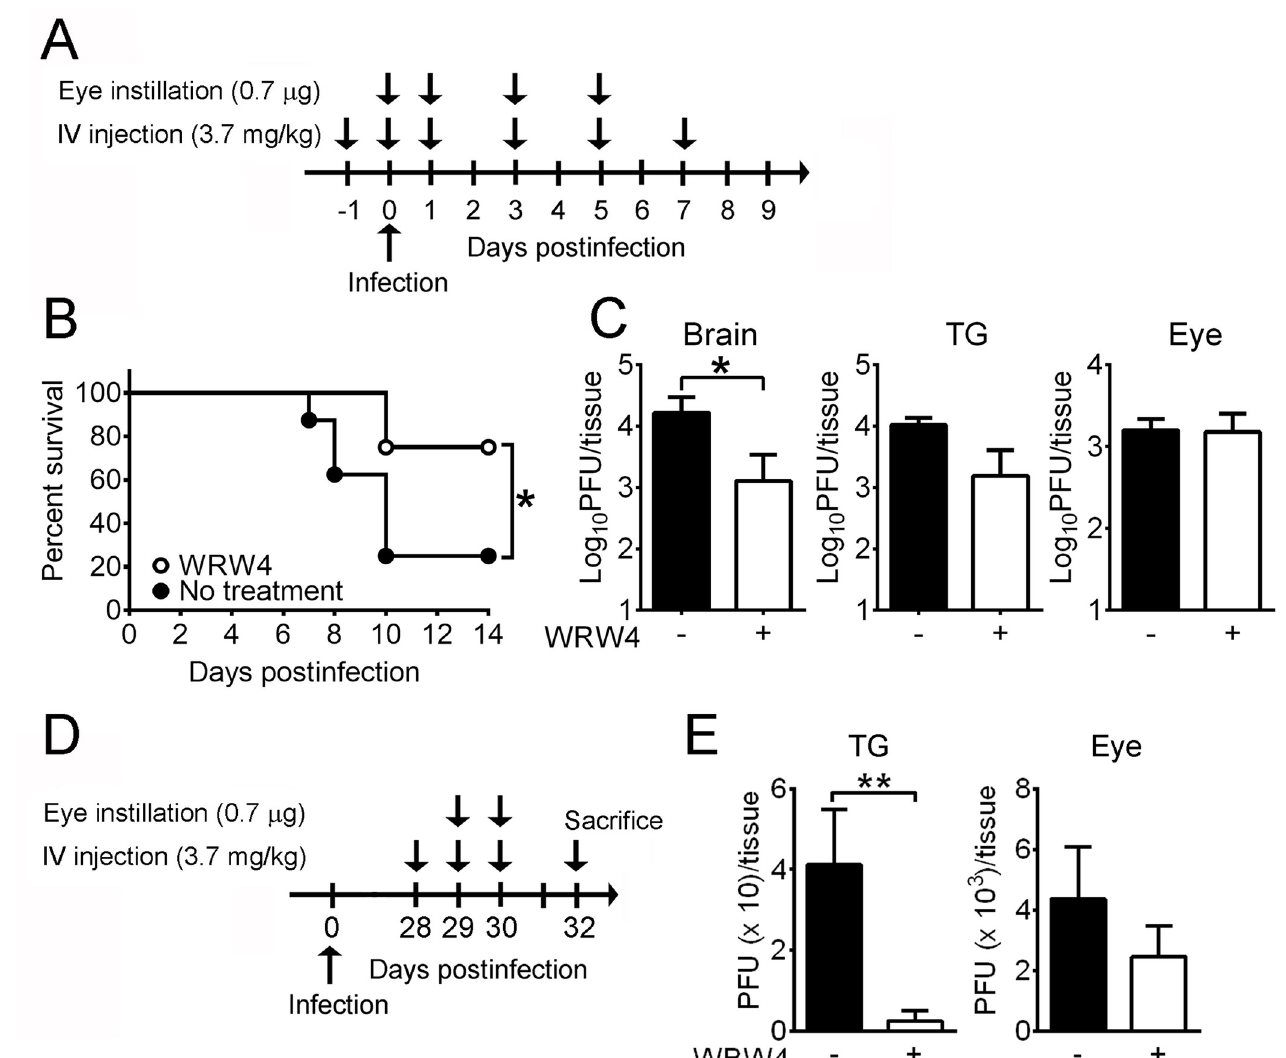
Fig 8. Blocking FPR2 reduces the the mortality rate and viral load in neural tissues of infected mice. ( A ) WT mice were treated without or with WRW4 on the eye and by intravenous (IV) injection and infected with HSV-1 as indicated. ( B ) The survival rates of infected mice treated without (No treatment; n = 8) or with WRW4 (WRW4; n = 8) are shown. ( C ) Viral loads in the indicated tissues of mice treated without (-) or with (+) WRW4 were determined at 5 dpi ( n = 5/ group). ( D ) BALB/c nude mice were infected with HSV-1 294 dl TKA, treated without (-) or with (+) WRW4 on the eye and by IV injection, and sacrificed as indicated. ( E ) Viral loads in the indicated tissues of mice treated without or with WRW4 were determined ( n = 8/group). Data show the mean + SEM in panels C and E. � P < 0.05 and �� P <